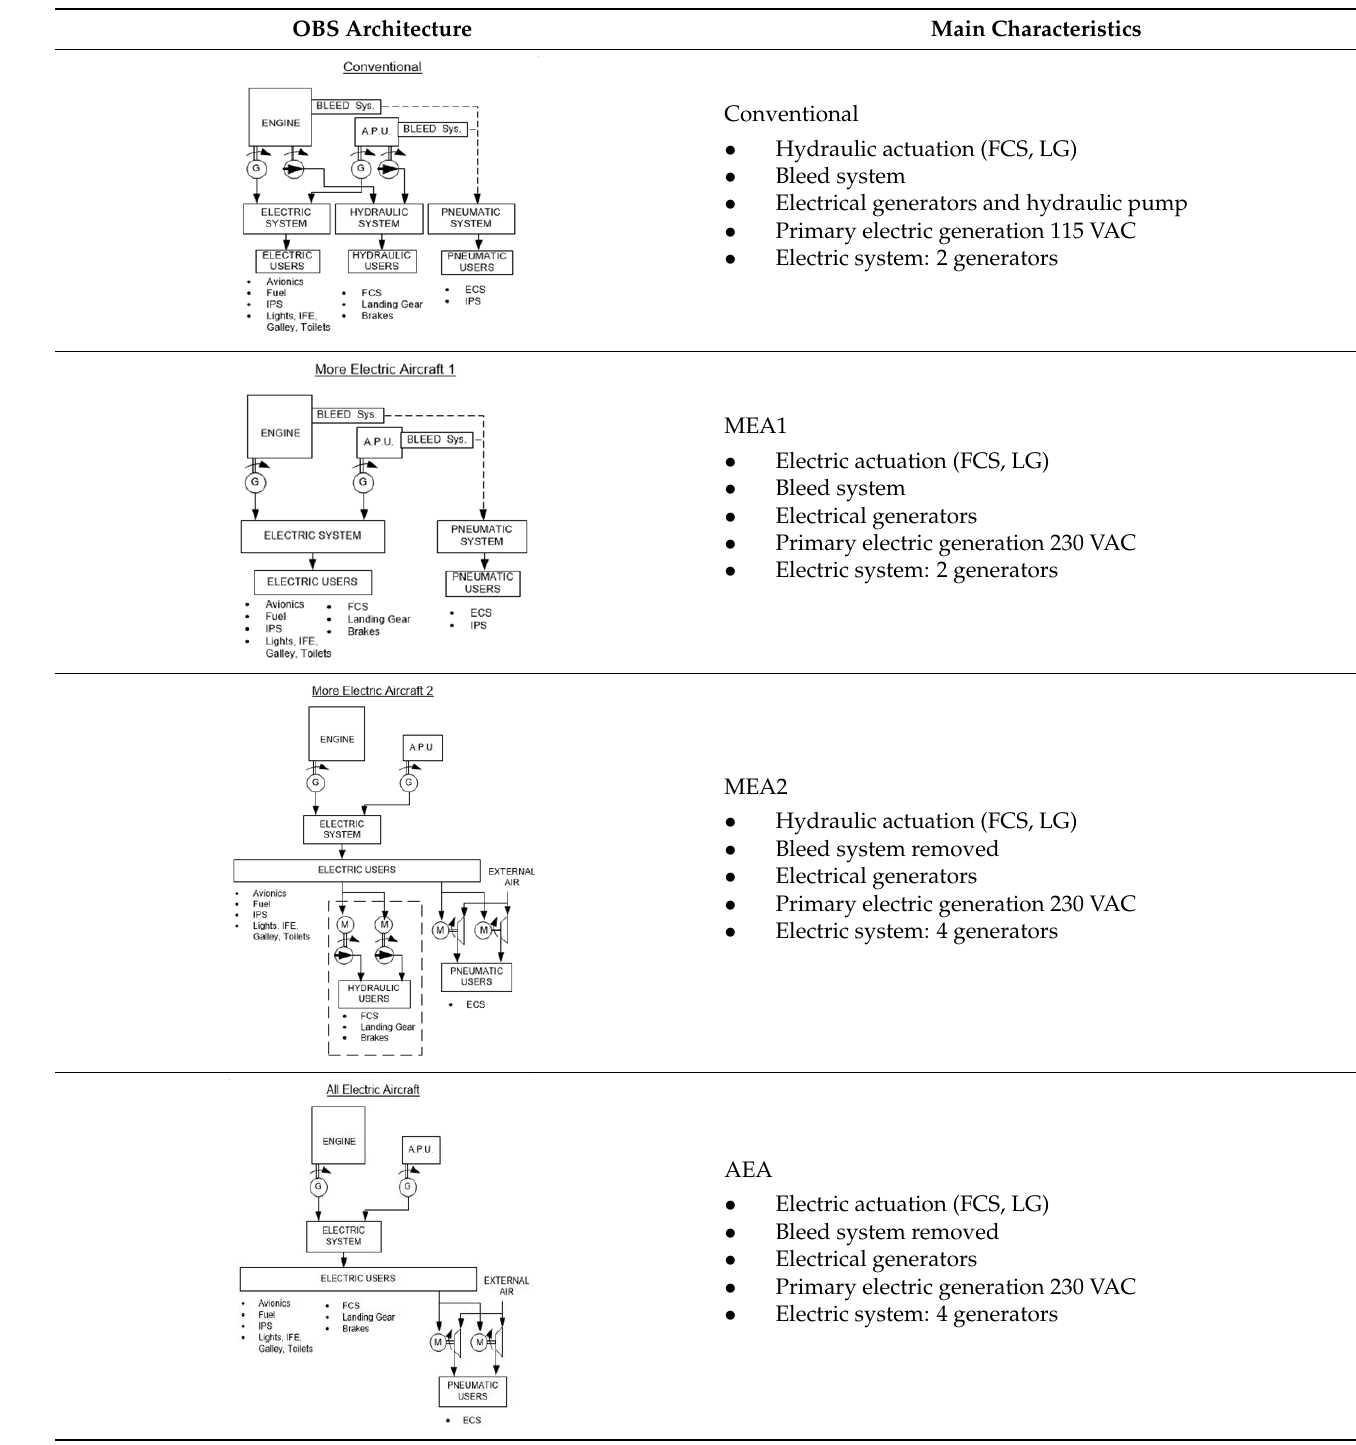
Table 3. The retrofit solution, considered for cost analysis. Retrofit